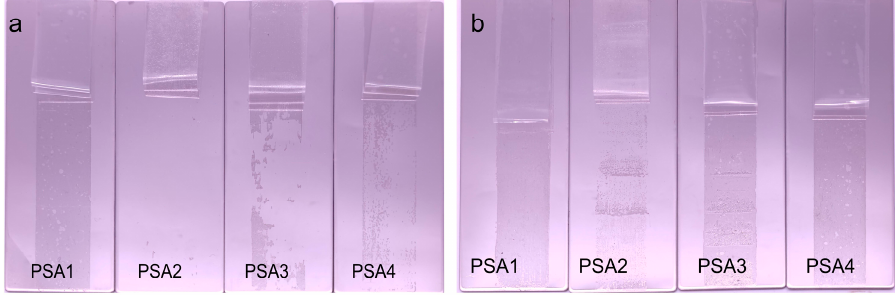
Figure 6. The residuals of WPU-PSAs at 25 °C ( a ) and 60 °C ( b